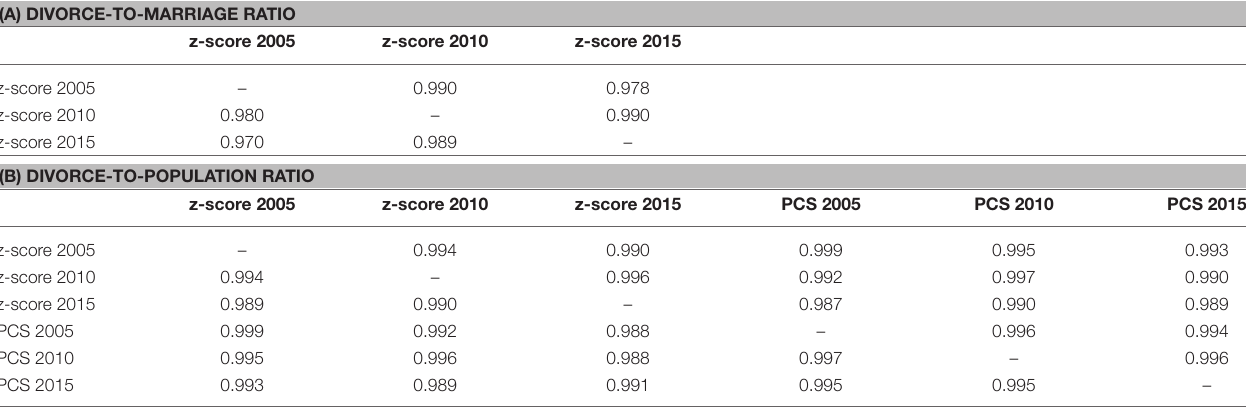
TABLE 2 | Correlation coefficients among aggregated scores (z-scores and principal component